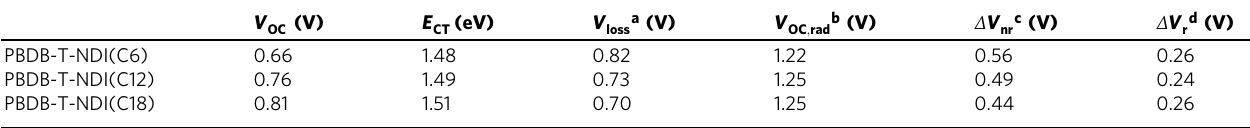
Table 1 Voltage loss values from the subgap EQE measurements for the solar cells based on DCDA